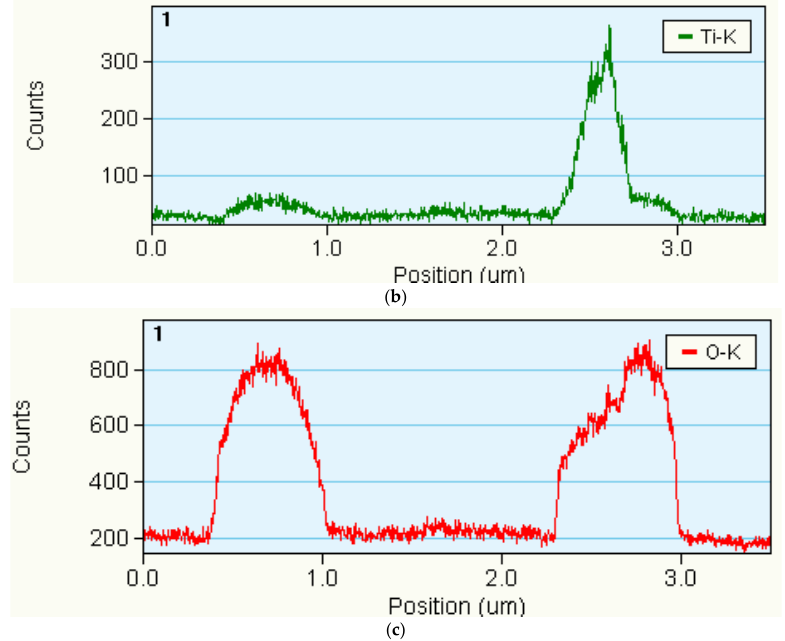
Figure 14. Spherical TiO precipitates in the hybrid welded joint made of steel S700MC. ( a ) precipitates; ( b ) linear analysis EDS of titanium concentration; ( c ) linear analysis EDS of oxygen concentration.